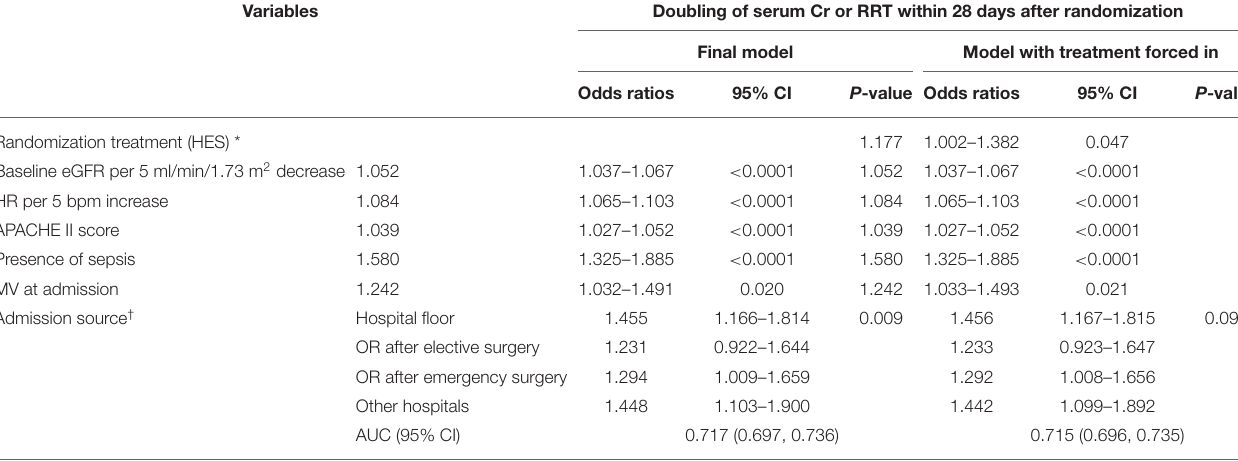
TABLE 4 | Sensitivity analysis of including randomization treatment in the multivariable regression model.